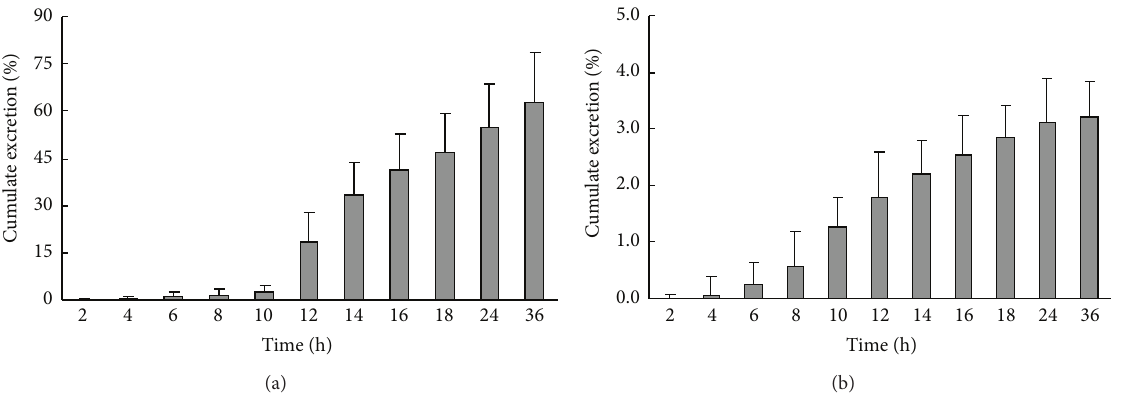
Figure 4: Cumulative excretion of ergosterol in faeces (a) and urine (b) of rats after an oral dose with a dosage of 100mg/kg. Faeces were collected after administration in different periods (0–2, 2–4, 4–6, 6–8, 8–10, 10–12, 12–14, 14–16, 16–18, 18–24, and 24–36 h).